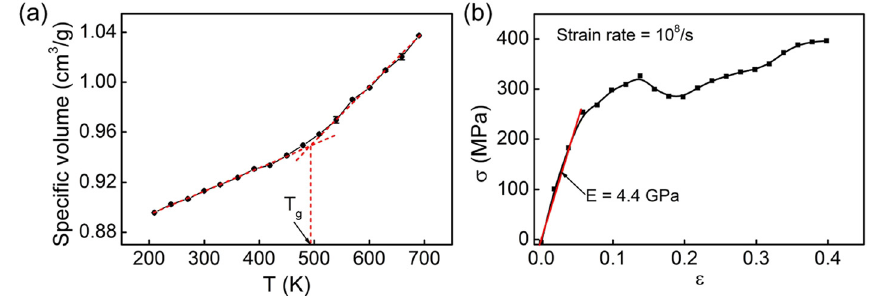
Figure 6: ( a ) The curve of speci fi c volume as a function of temperature for the cross - linked epoxy. T g of the cross - linked epoxy is about 489 K, close to the experimental result. ( b ) The stress – strain curve of the cross - linked epoxy under a fi xed strain rate of 10 8 /s. Young ’ s modulus is about 4.4